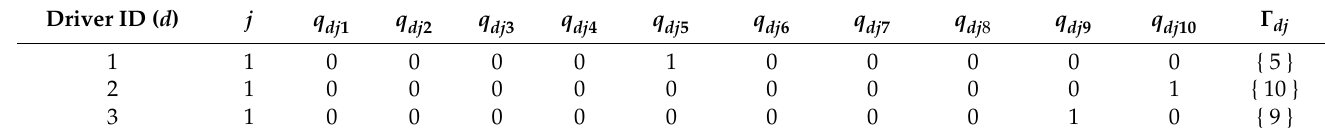
Table 6. The number of seats in the bids submitted by drivers.